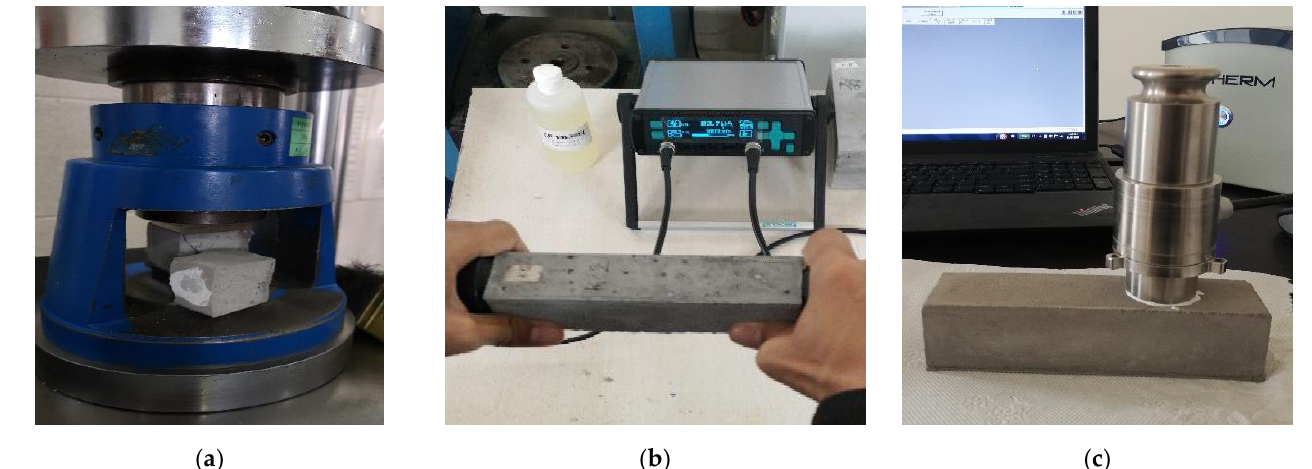
Figure 3. (a) Compression, (b) ultrasound and (c) thermal conductivity tests on geopolymer mor- Figure 3. ( a ) Compression, ( b ) ultrasound and ( c ) thermal conductivity tests on geopolymer tar.